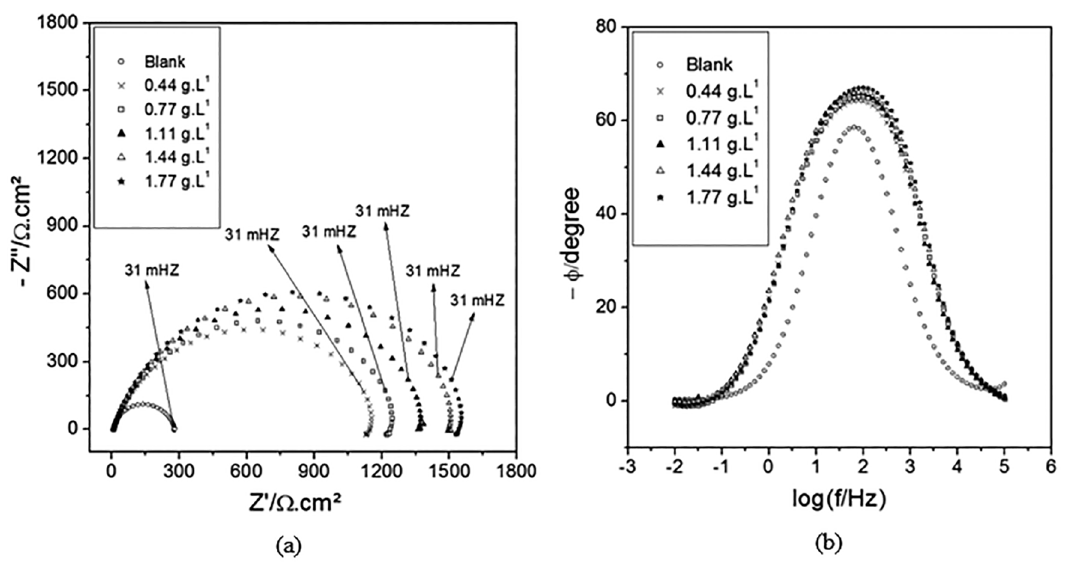
Figure 3. EIS diagrams obtained for AISI 1020 carbon steel after 120 min of immersion in 0.5 mol.L -1 HCl in absence and presence of different amounts of castor bark powder: (a) Nyquist and (b) phase angle x log f